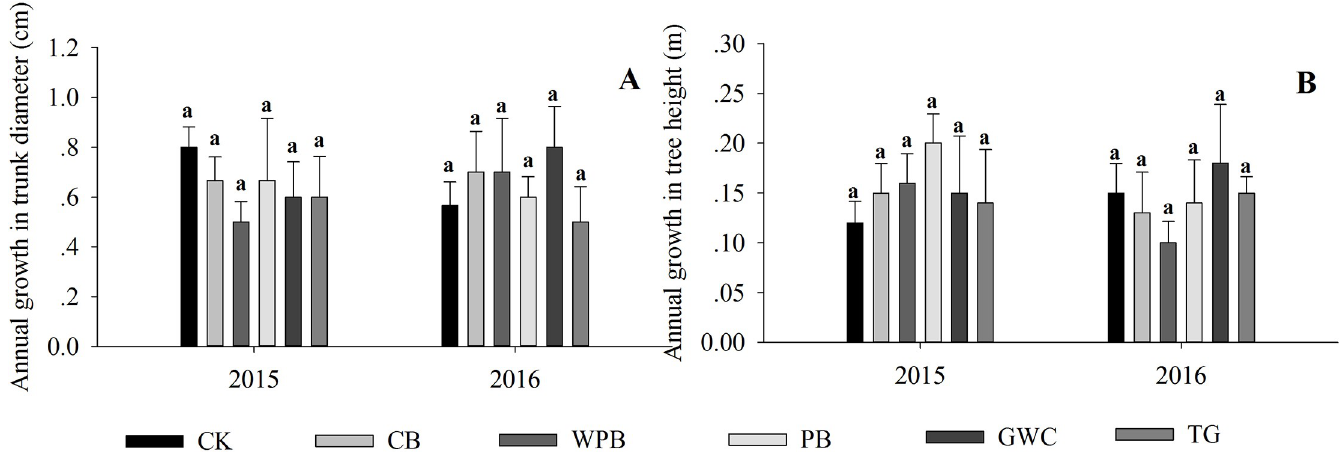
Fig 4. Annual increase in trunk diameter and tree height of trees in tree pits treated with bare soil (CK), cobblestones (CB), water permeable bricks (WPB), pine barks (PB), green waste compost (GWC) and turf grass (TG). Different letters above the error bars indicate significant differences between treatments ( p < 0.05, n = 3). The error bars indicate standard